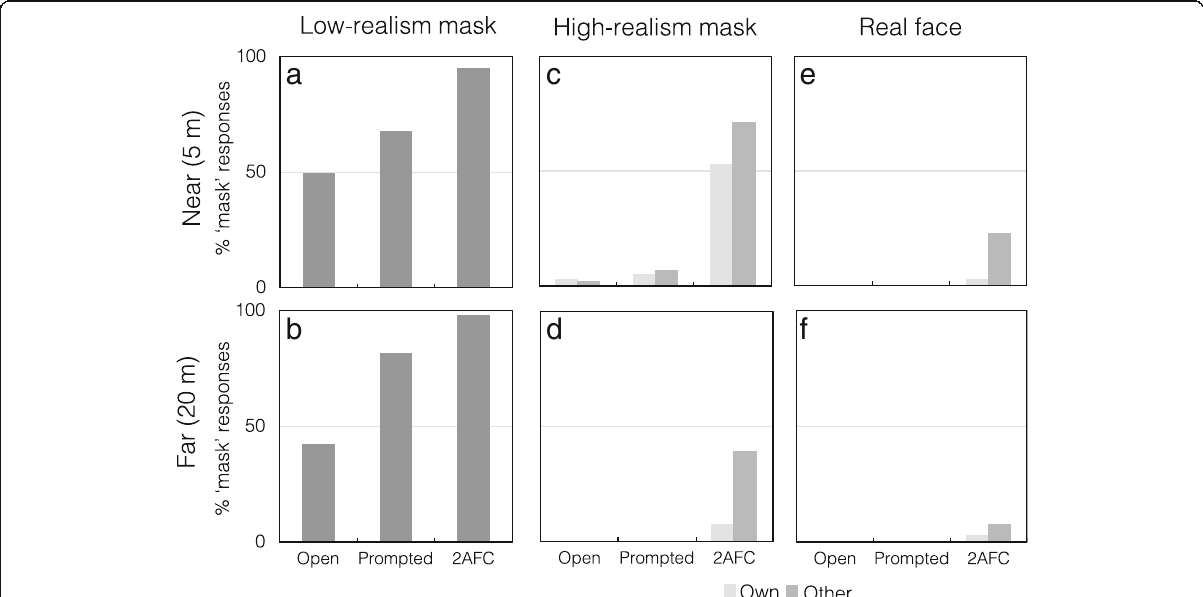
Fig. 5 Mask detection data from Experiment 3. Bars show the percentage of ‘ mask ’ responses to Open, Prompted and 2AFC questions about the experimental confederate. Responses are broken down by realism ( a , b Low-realism mask ; c , d High-realism mask ; e , f Real face ) and by viewing distance ( a , c , e Near ; b , d , f Far ). For the High-realism mask and Real face conditions, responses are shown separately for Own-race (light grey) and Other-race (mid grey). Sample sizes for each panel: a , 44; b , 41; c , 82; d , 78; e , 81; f ,